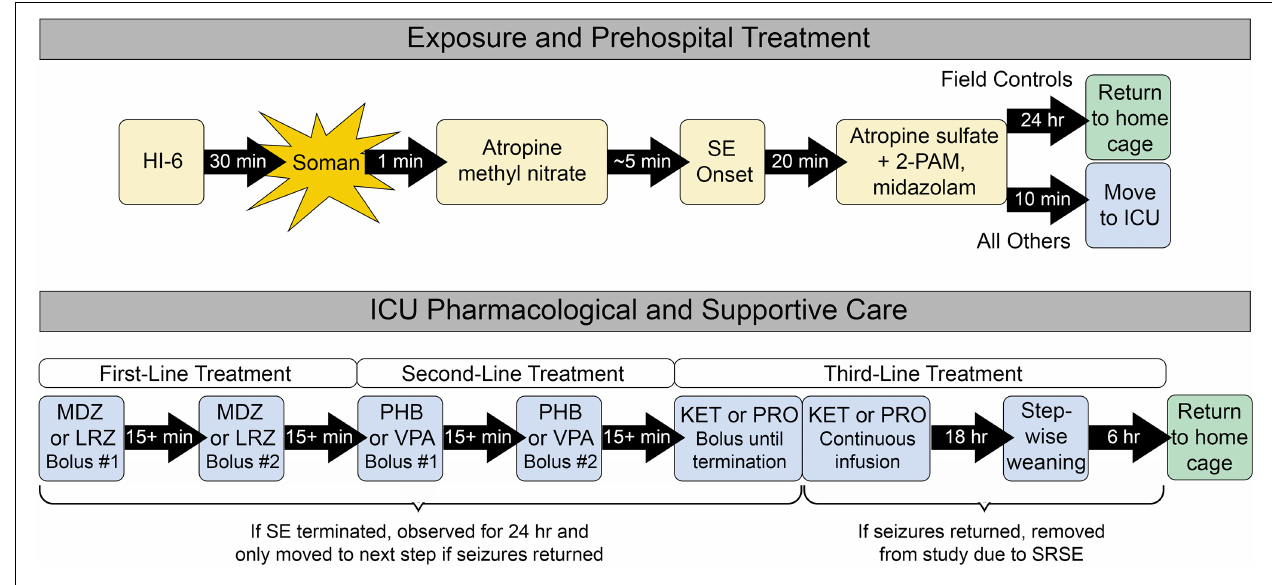
FIGURE 1 | Exposure, prehospital treatment, and ICU care paradigm. All rats received prehospital treatment. Field control rats remained in the prehospital environment for up to 24 h and did not receive further supportive care. ICU controls and ICU-treated rats were transferred to the ICU environment, where they received supplemental oxygen and thermal support. Only the ICU-treated group received additional first-, second-, and third-line pharmacological therapies as needed to control seizure activity. All control rats that survived for 24 h after prehospital treatment and all ICU-treated rats that remained seizure-free for 24 h were returned to their home cage for daily monitoring, behavioral testing 9 days after exposure, and euthanasia 11 days after